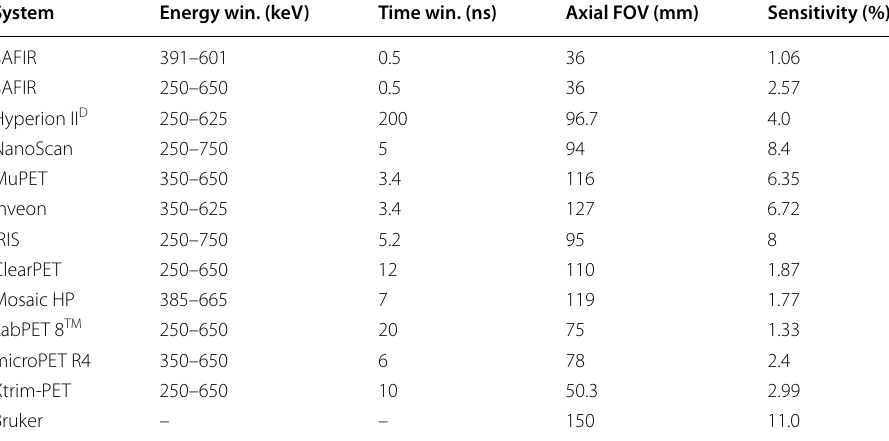
Table 3 Comparison of the peak sensitivity of different preclinical PET scanners. Data are taken from [5–15]